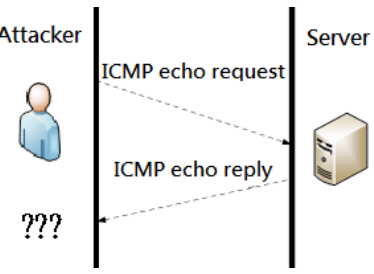
Figure 3. Normal ICMP diagram.